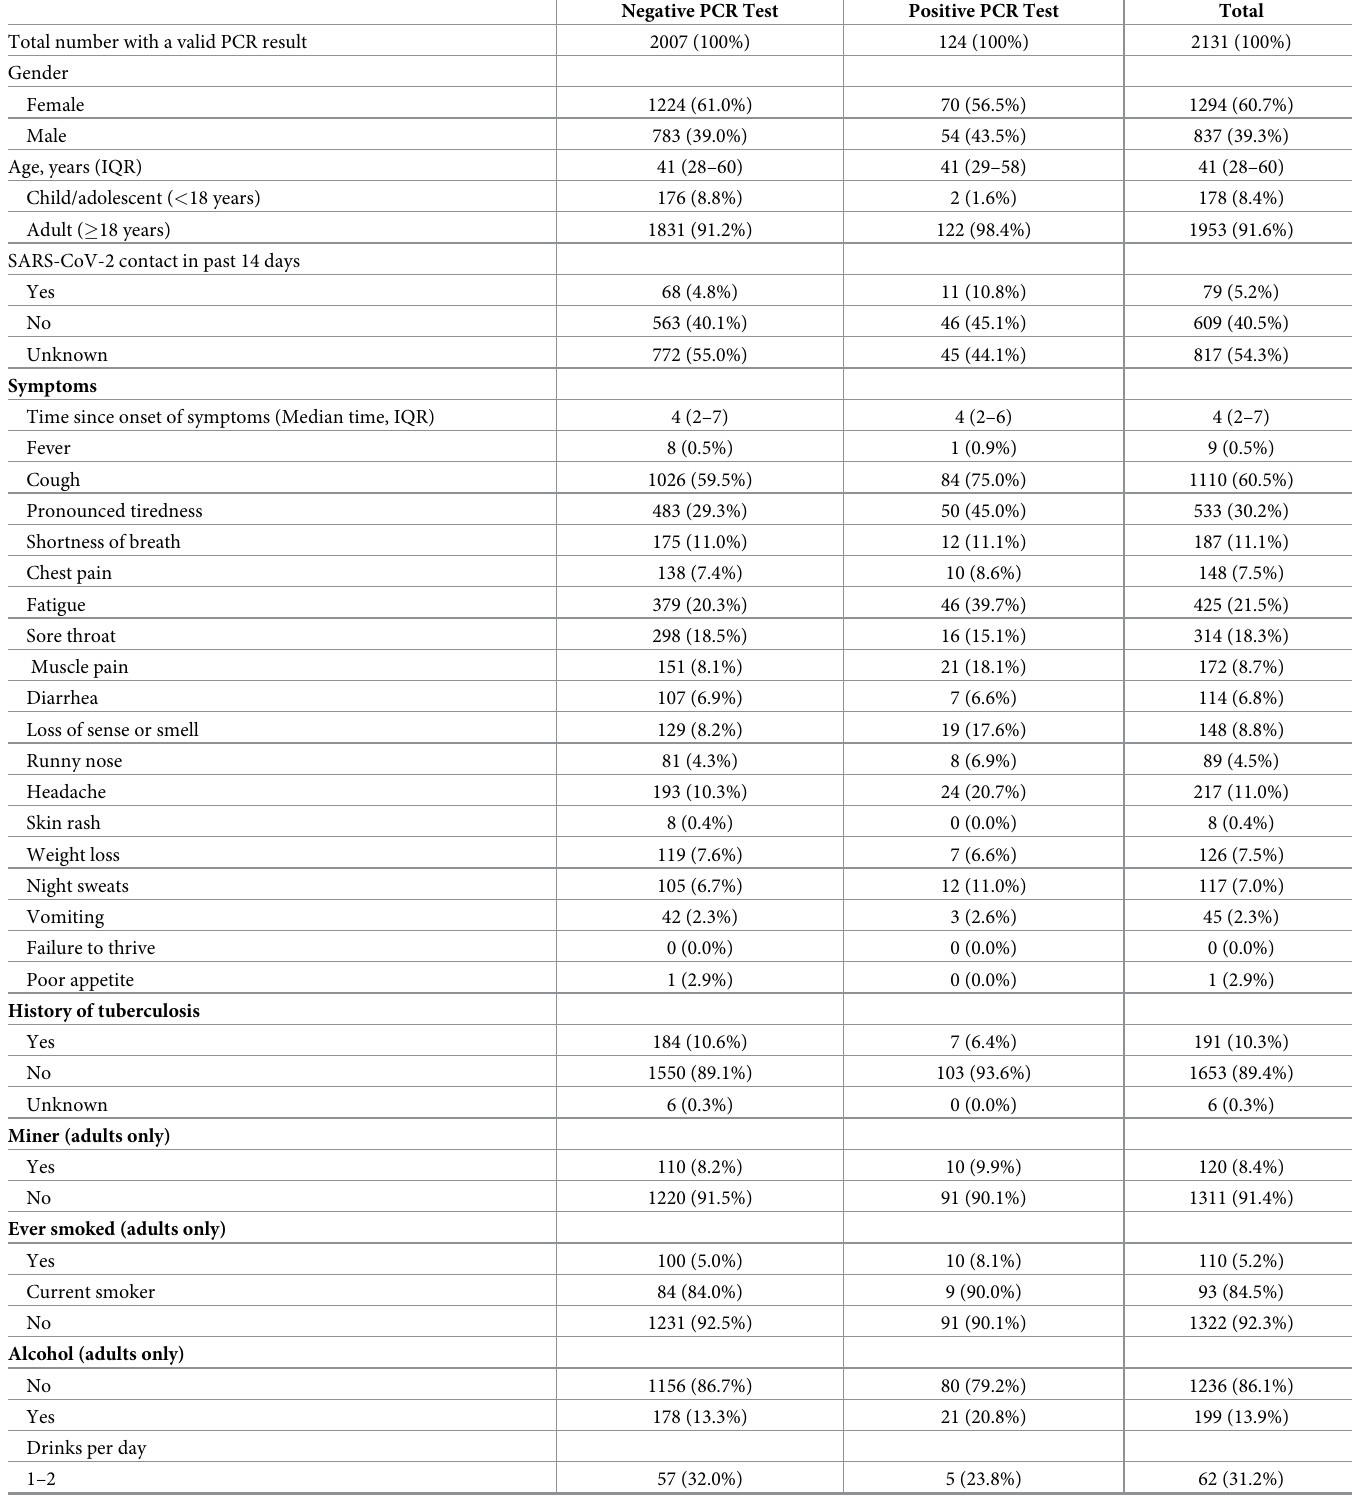
Table 1. Demographic and clinical characteristics of study